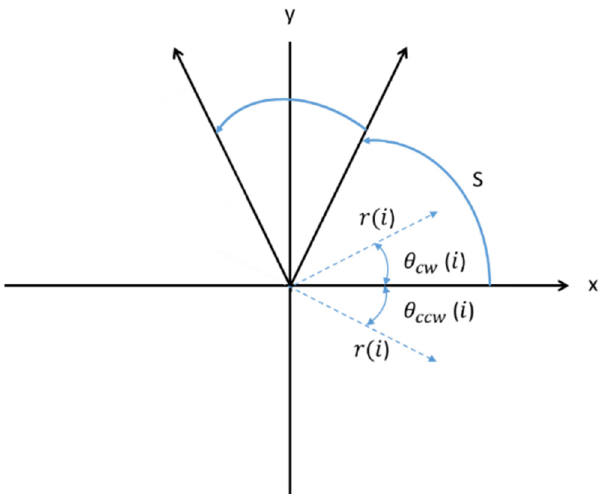
Figure 11. Snowflake image calculation principle.